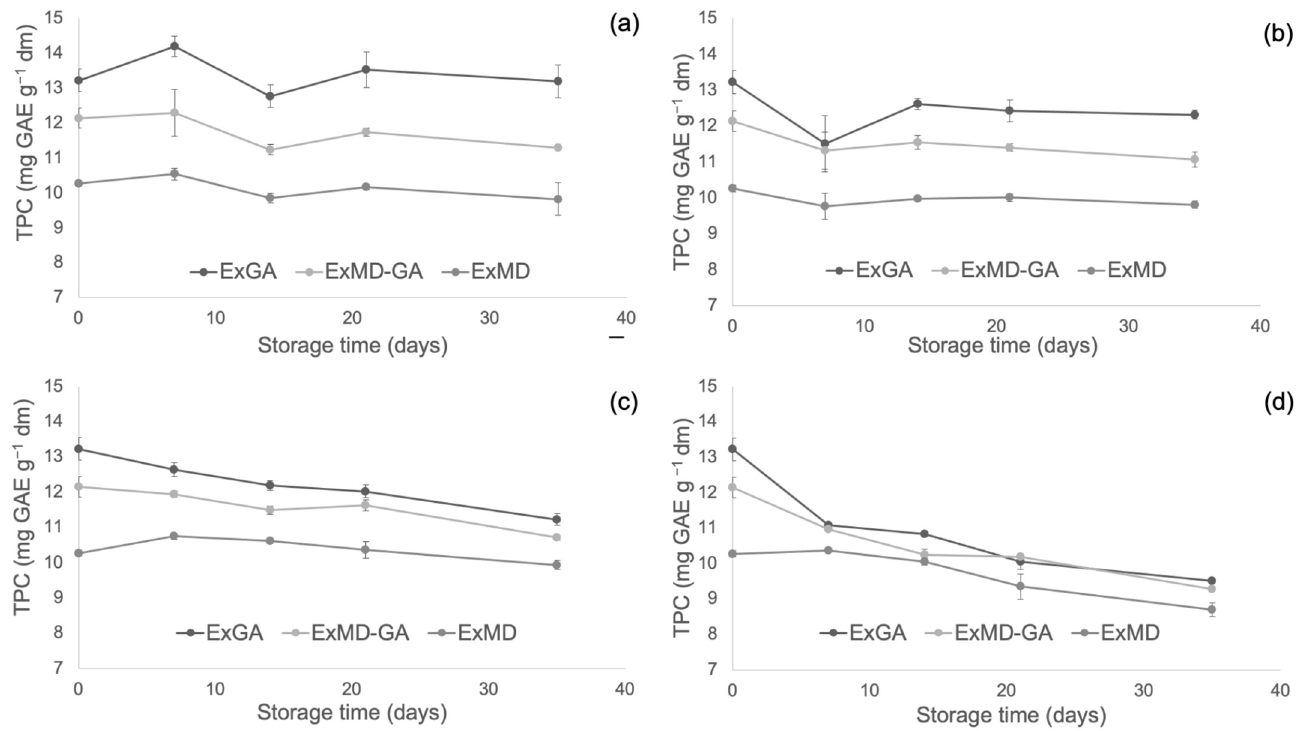
Figure 4. Total phenolic content (TPC) of encapsulated hop extract during storage at different temperatures: 5 °C ( a ), 20 °C ( b ), 35 °C ( c ), 50 °C ( d ).